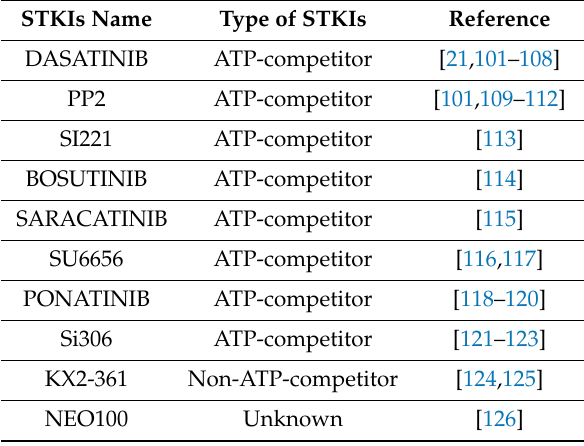
Table 1. SRC tyrosine kinase inhibitors (STKIs) in glioblastoma